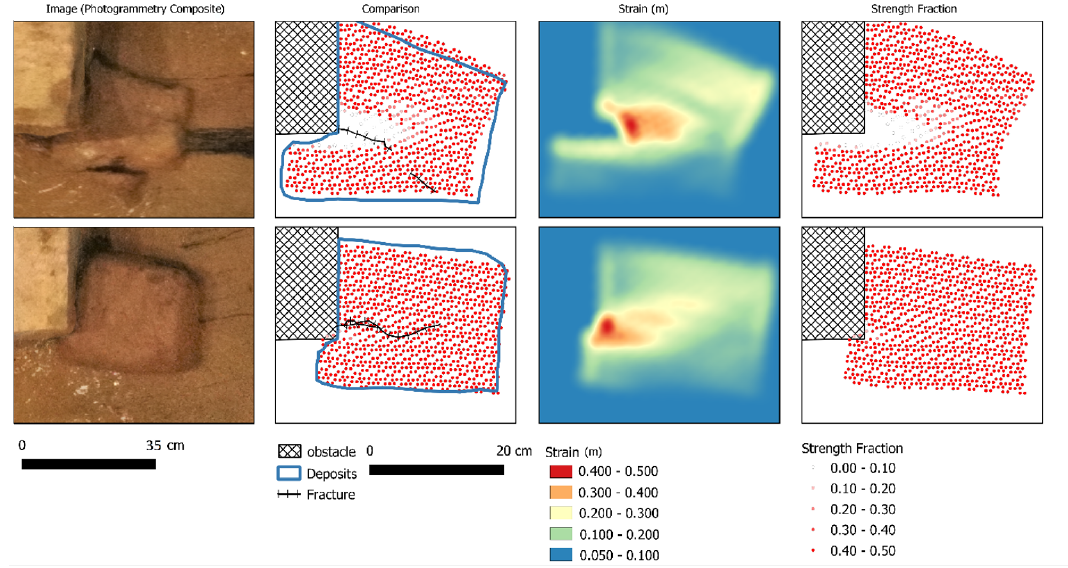
Figure 5. A comparison of the final deposits of the simulations and the mapped final deposits and cracks within the material: (from left to right) photogrammetry mosaic, comparison of simulation results to mapped flume experiment, strain, final strength fraction